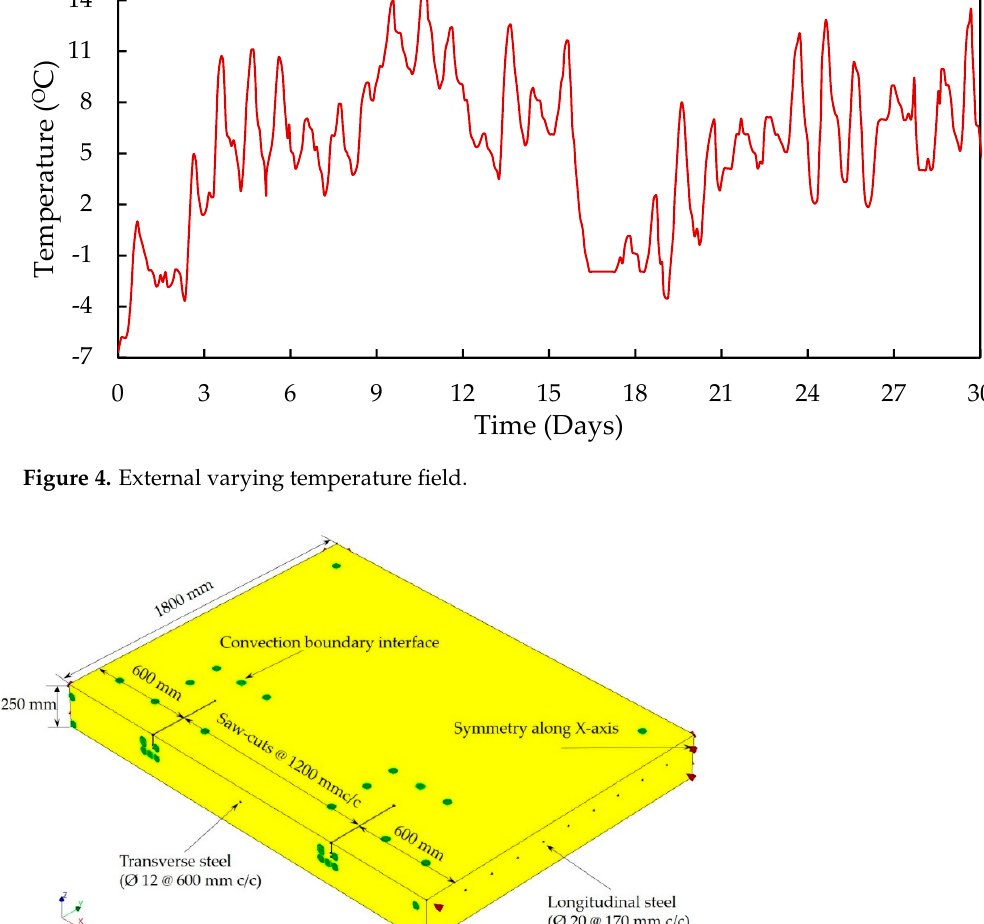
Figure 11. Comparison of maximum concrete tensile stress over the saw-cut tips along the length of concrete slab for different saw-cut depths.